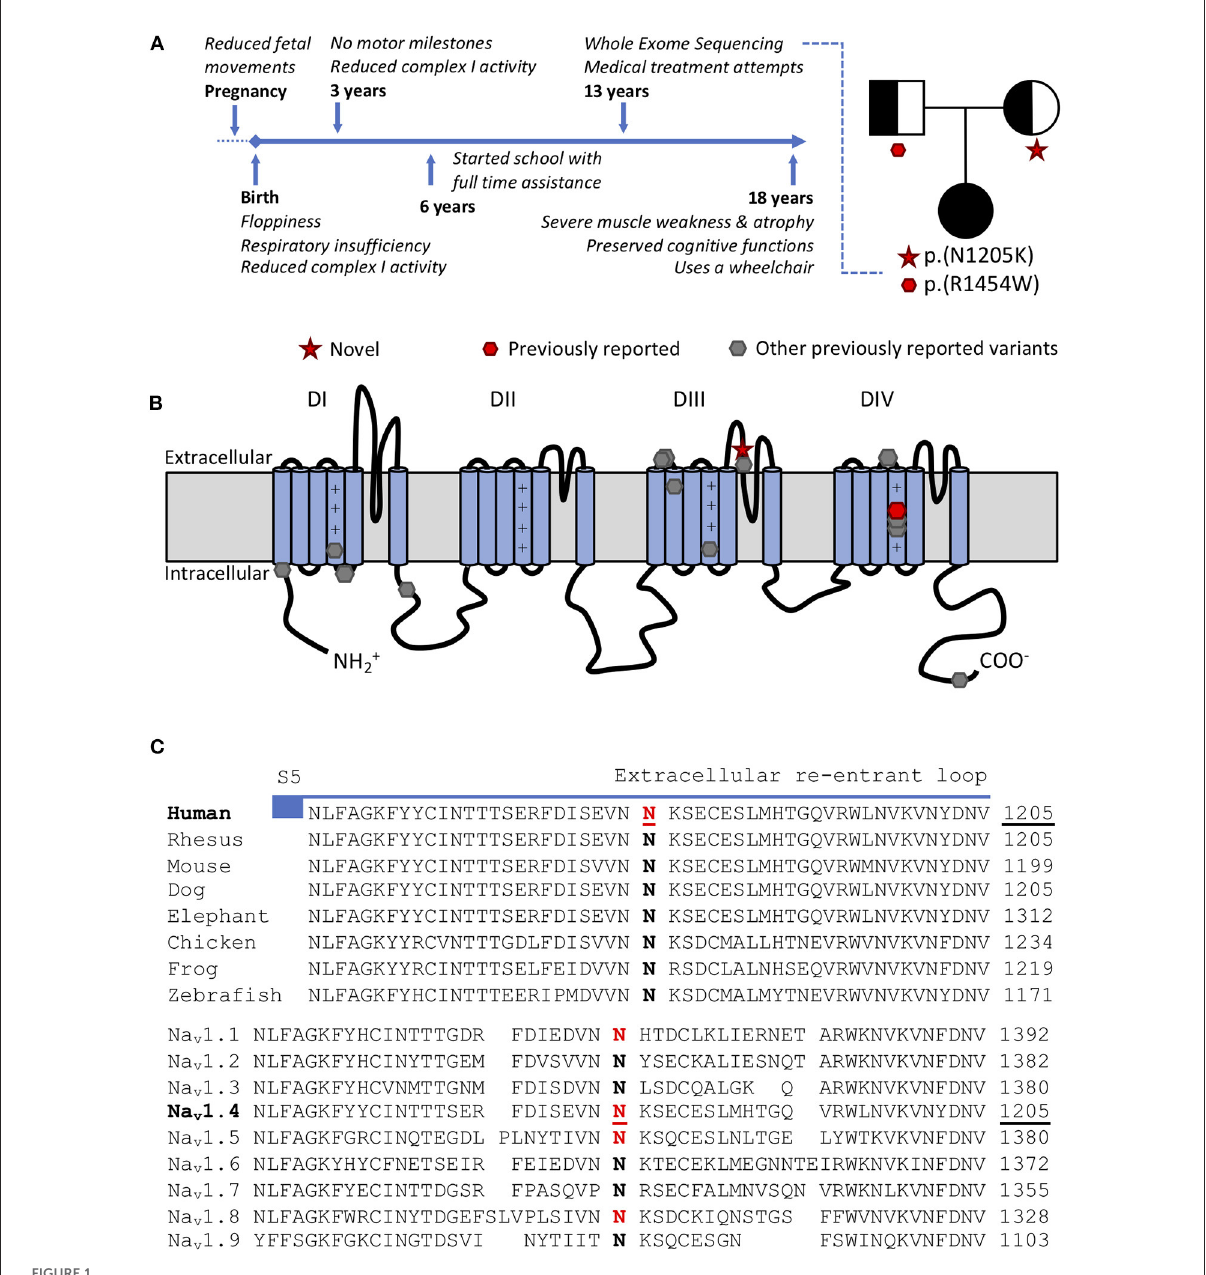
FIGURE1 (A) Time-line and family tree. Each parent is asymptomatic and a carrier for one variant. (B) Scheme of the pore forming alpha subunit of Na V 1.4 with locations of CMS/myopathy-linked SCN4A variants: red p.(N1205K) and p.(R1454W) (compound heterozygous), gray (other previously reported variants): p.R104H, p.R225W, p.S246L, p.Q470X, p.A1049VfsX50, p.D1059N, p.R1059X, p.R1135C, p.C1205F, p.V1442Q, p.R1457H p.R1460W/Q, p.H1782QfsX85. (C) Amino acid conservation in the extracellular S5-S6 reentrant loop region of domain III among Na V